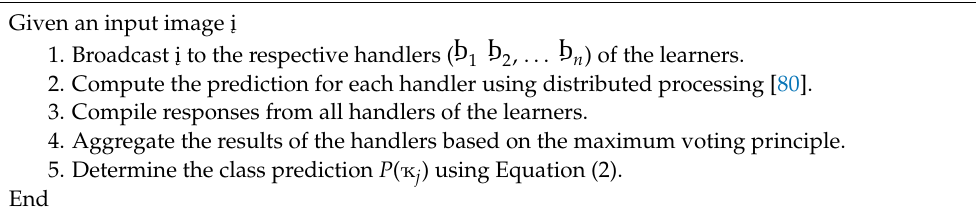
Algorithm 1: Simple Majority Voting Ensemble Deep Learning